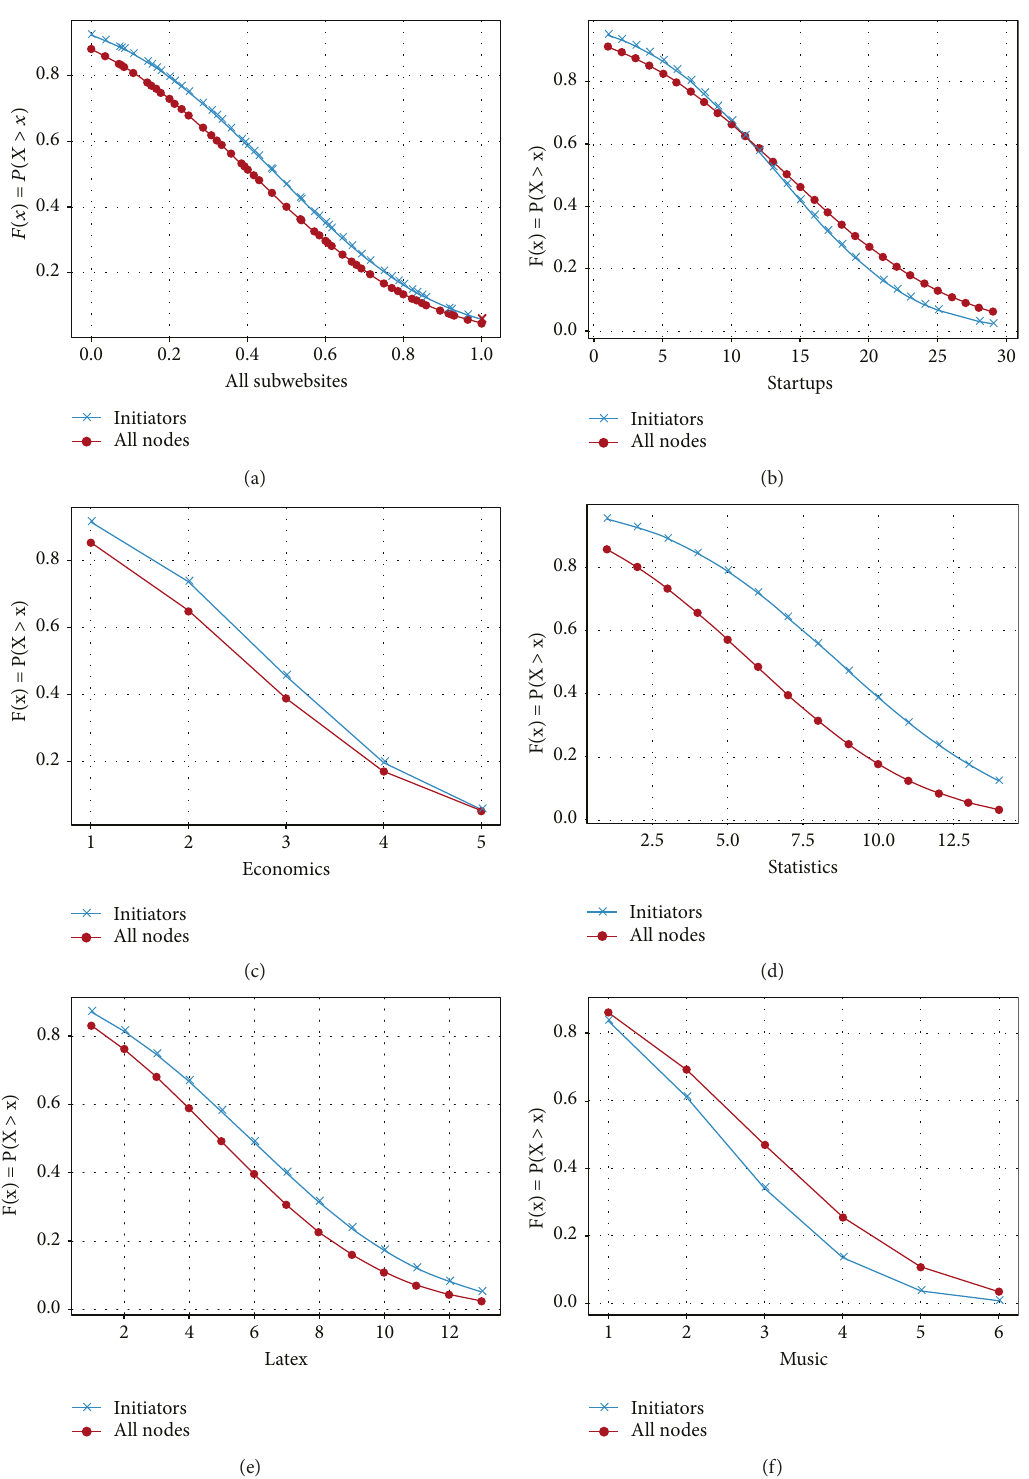
Figure 6: The fi gure shows the CCDF of the probability distribution of the coreness of all nodes in the network G of the initiators for all subwebsites combined (a). In addition, (b) to (f) show the CCDF for each subwebsite alone. Note that the x -axis scale in (a) is scaled to allow for proper comparison, as network sizes are di ff erent across di ff erent